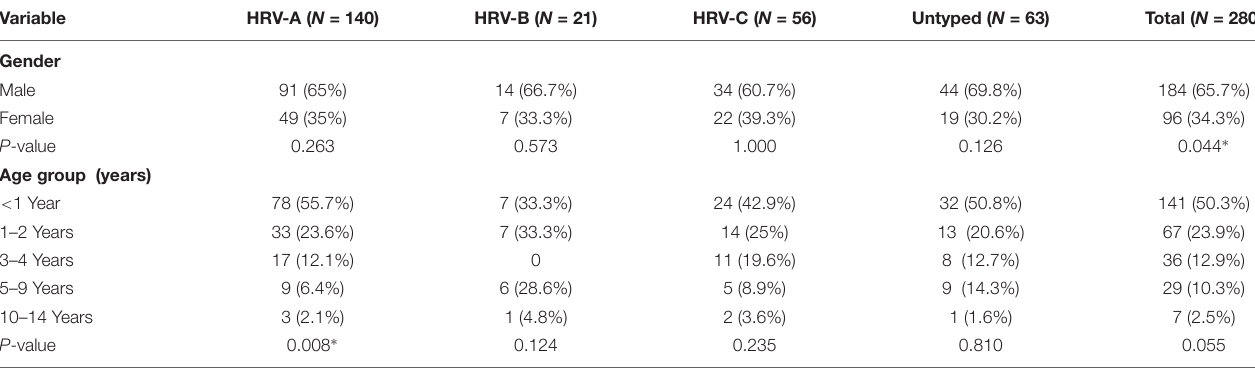
TABLE 1 | Population demographic of HRV-positive